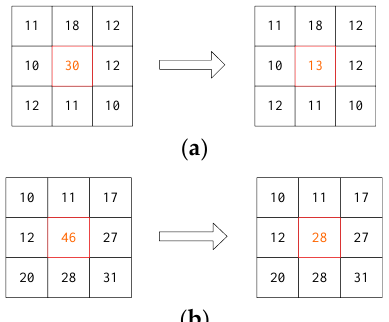
Figure 6. Denoising algorithm in this paper. (a) Diagram of noise removal; (b)diagram of restoring the energy of the star.